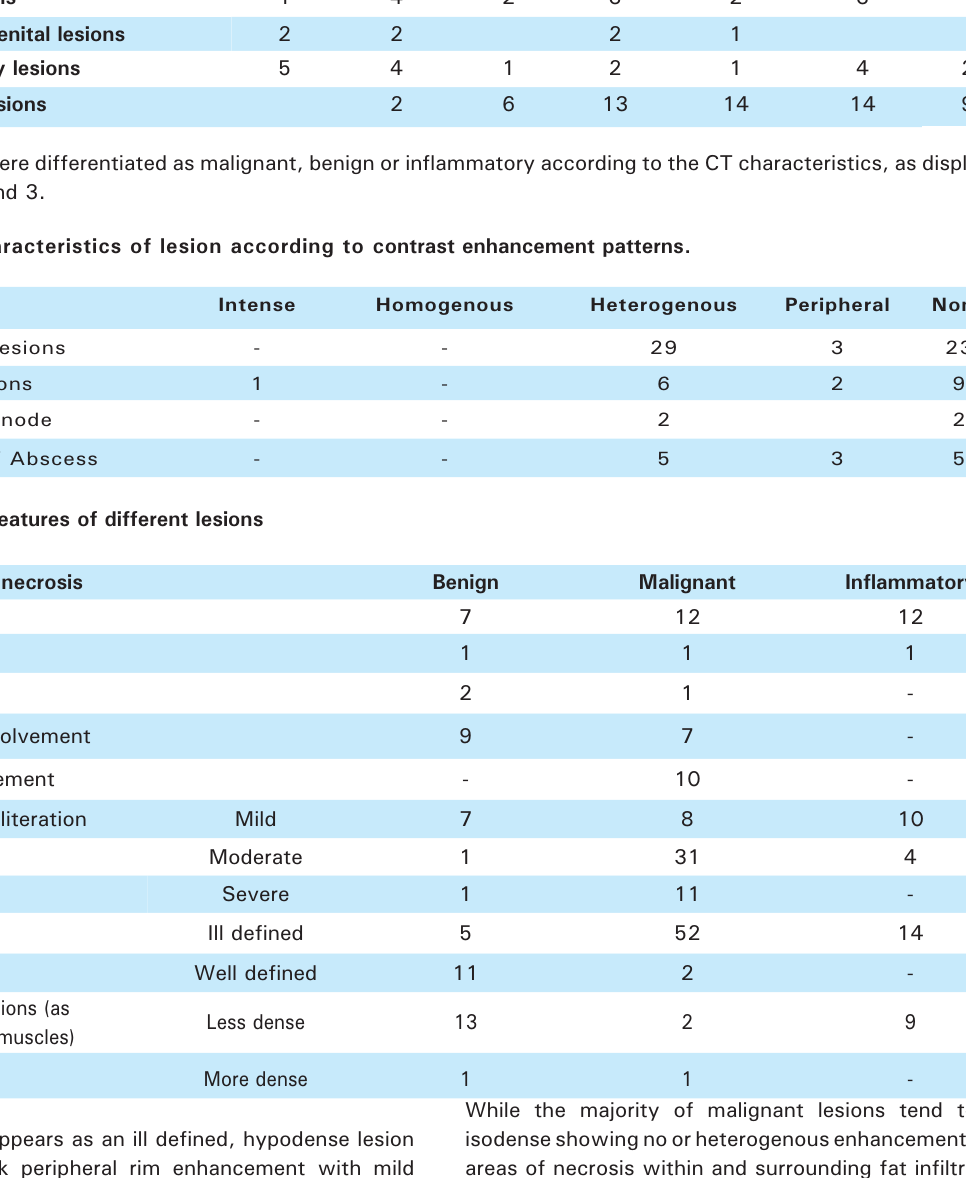
(Figure 3). Bony/laryngeal cartilage in(cid:2) ltration were seen in 11 cases: 3 cases of well-differentiated SCC, 6 cases of moderately-differentiated SCC, a case each